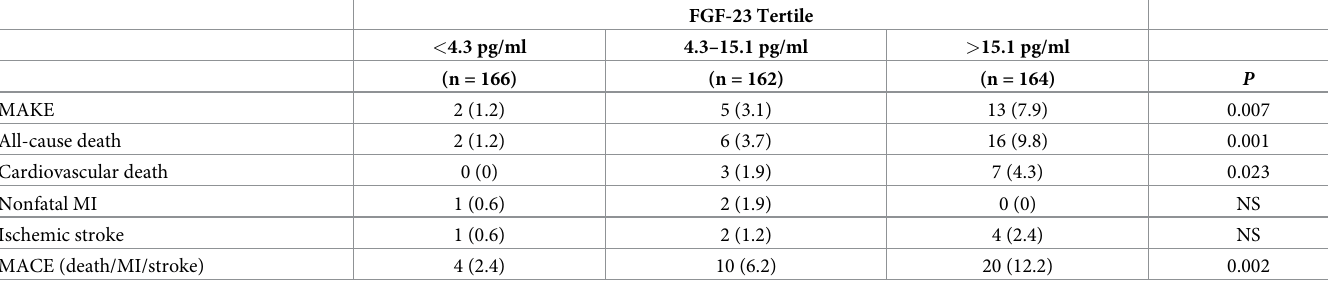
Table 2. Adverse events based on tertiles of serum FGF-23